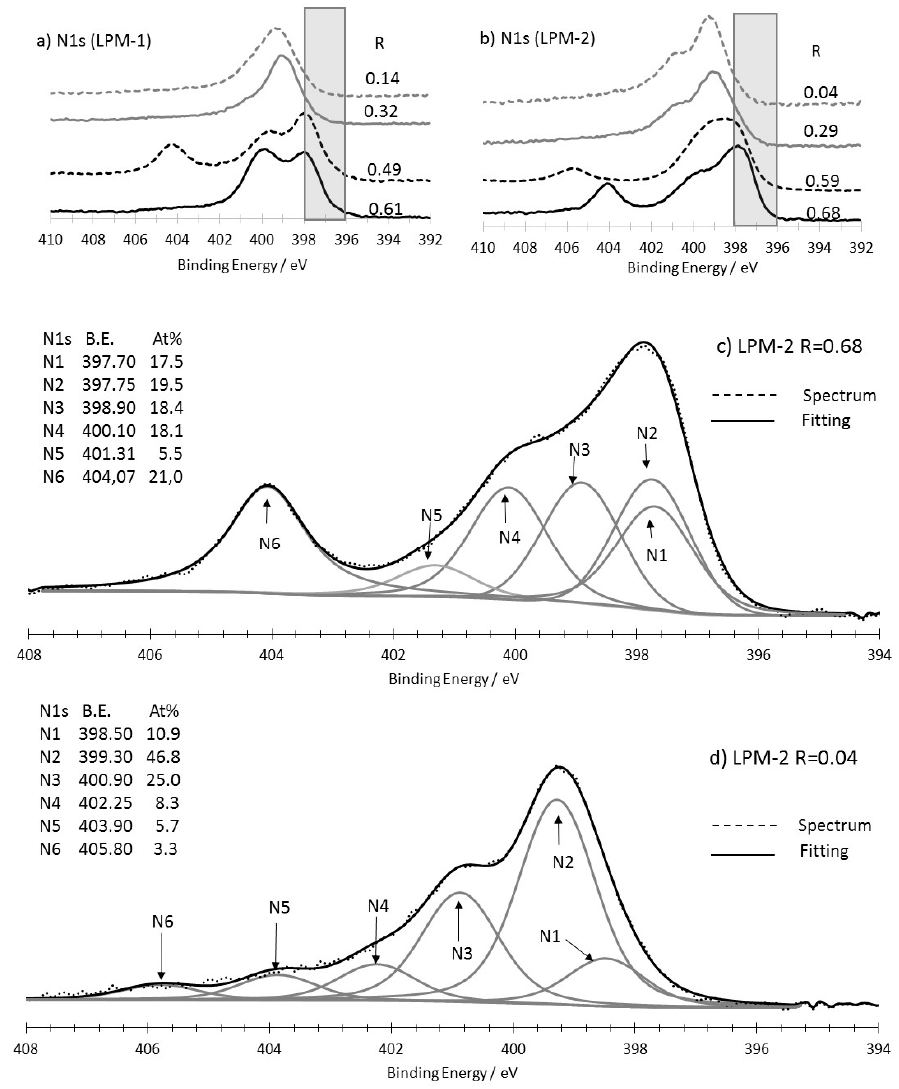
Figure 8. ( a , b ) N1s core level features as a function of R for ( a ) LPM-1 and ( b ) LPM-2. Grey area shows the binding energy region in which nitride iron can be found. Intensities are normalized; ( c , d ) are tentative peak fitting for LPM-2 at ( c ) R = 0.68 and ( d ) R = 0.04. Fitting components are labelled N1 to N6 and relative weights and binding energies are listed in the figures.